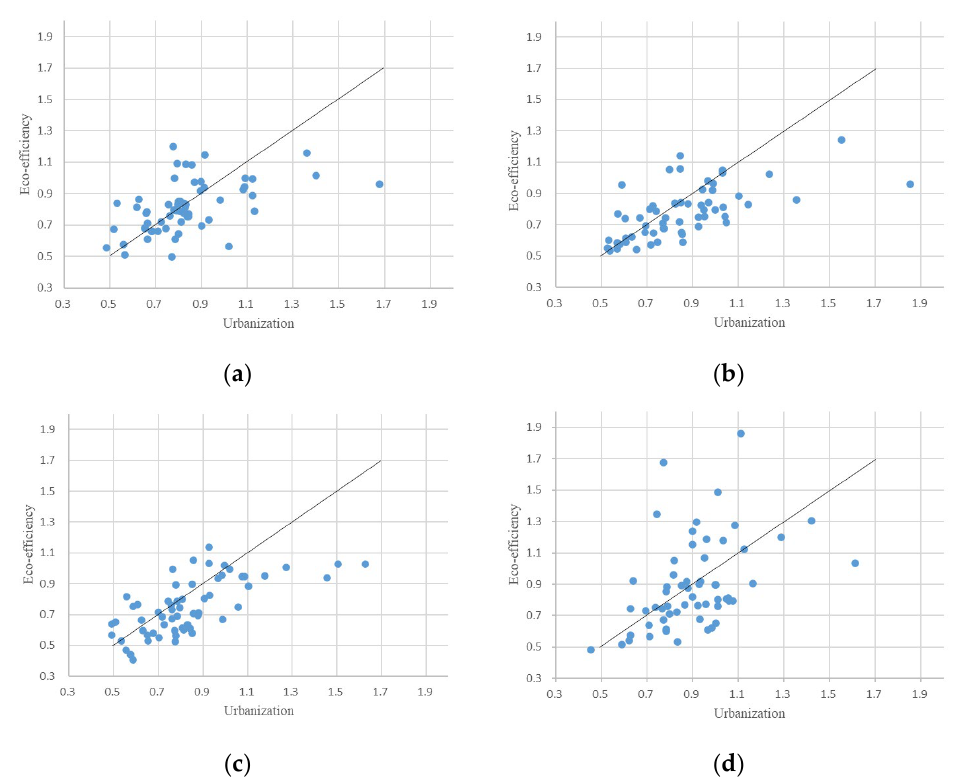
Figure 8. The relative development of urbanization efficiency and ecological efficiency in cities in the Yellow River basin, China. ( a ): 2006, ( b ): 2010, ( c ): 2014, ( d ): 2019.